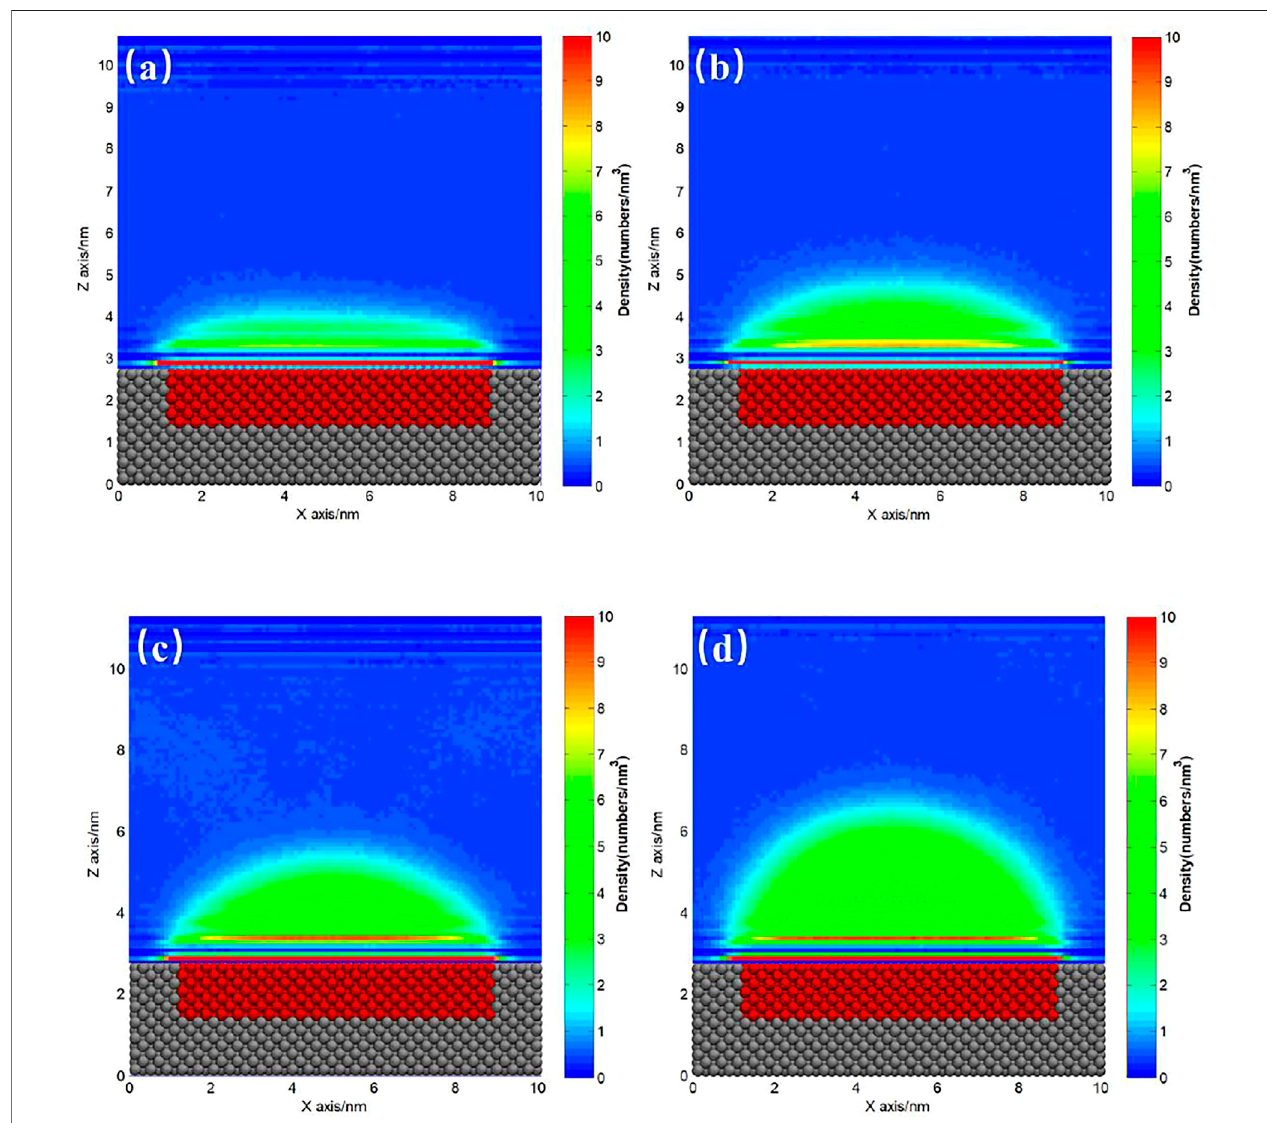
FIGURE 5 | Gas density distribution map averaged from 20 to 120 ns for S H patterned hydrophilic substrate. (A) 200, (B) 250, (C) 300, (D) 400 gas molecules.